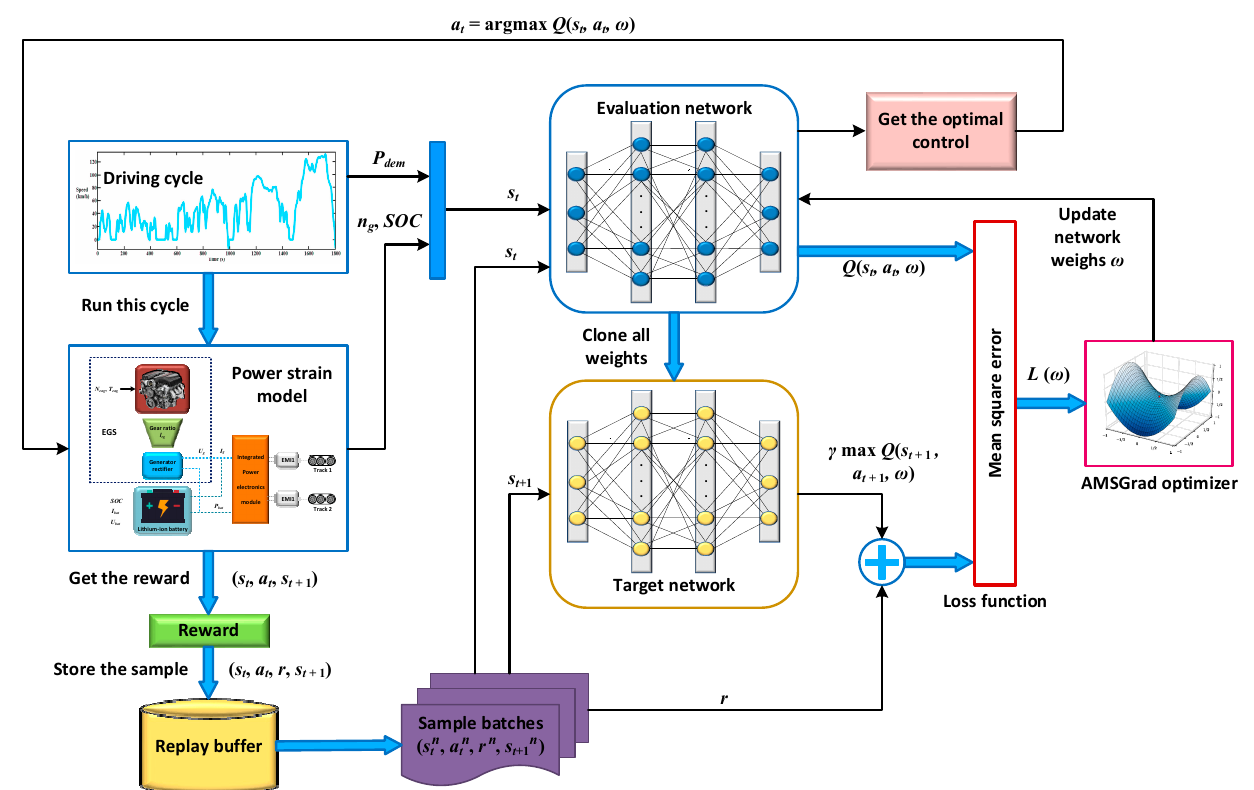
Figure 9. Advanced energy management strategy framework for EV.